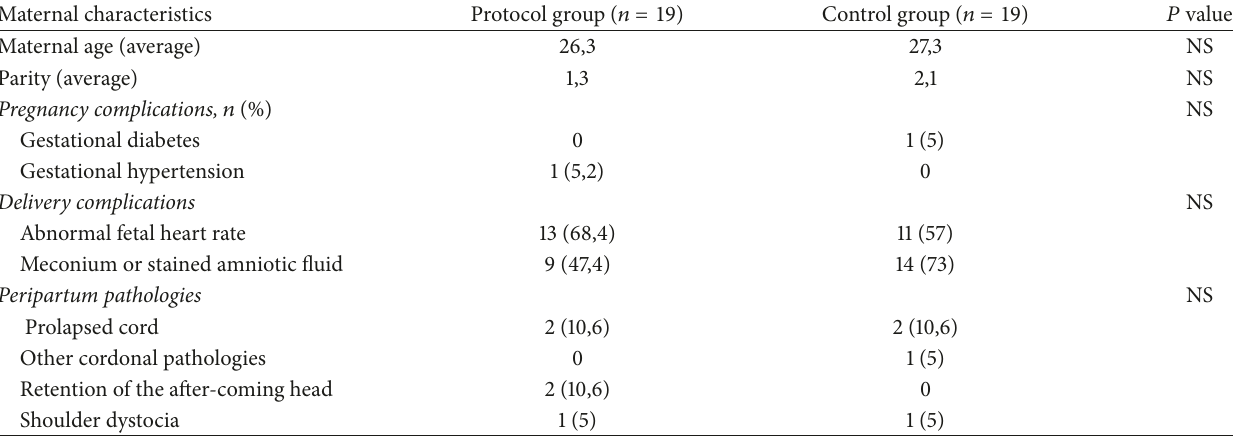
Table 1: Maternal characteristics.